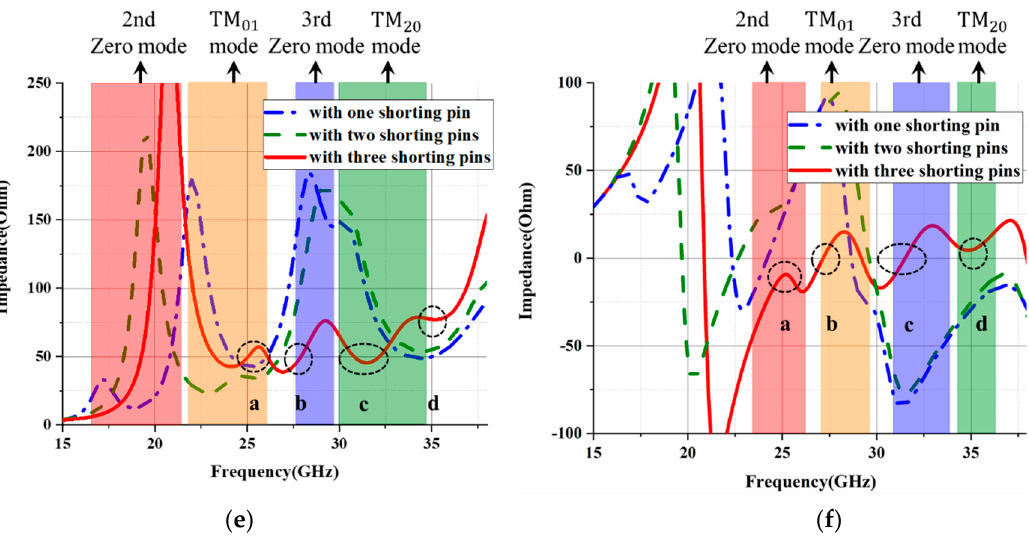
Figure 2. Resonance maps including 1st zero mode, 2nd zero mode, TM 01 mode, 3rd zero mode and TM 20 mode. ( a , b ) Numerically calculated real and imaginary impedance from theoretical analysis with and without shorting pin. ( c , d ) Numerically calculated real and imaginary impedance from theoretical analysis with different number of shorting pins. ( e , f ) Simulated real and imaginary impedance from ANSYS HFSS with different number of shorting pins.